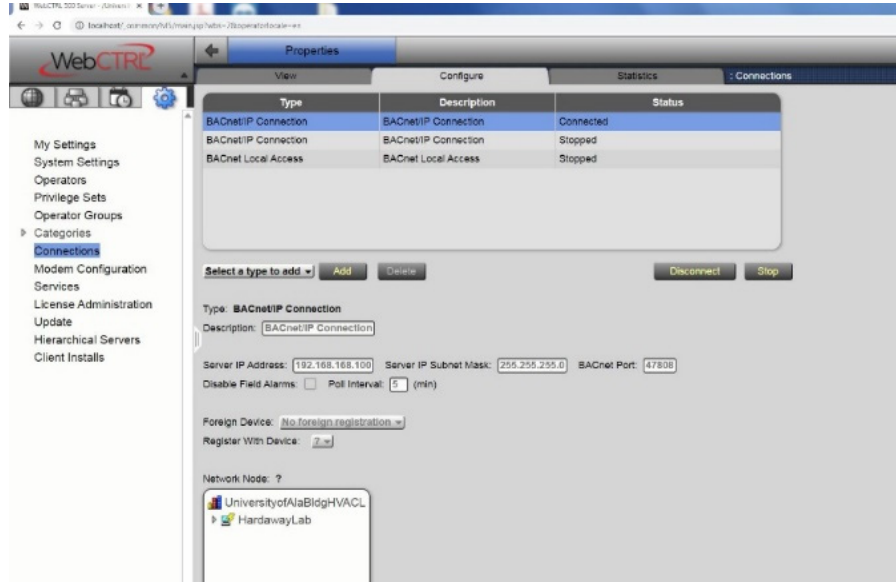
Figure 13. WebCTRL platform.